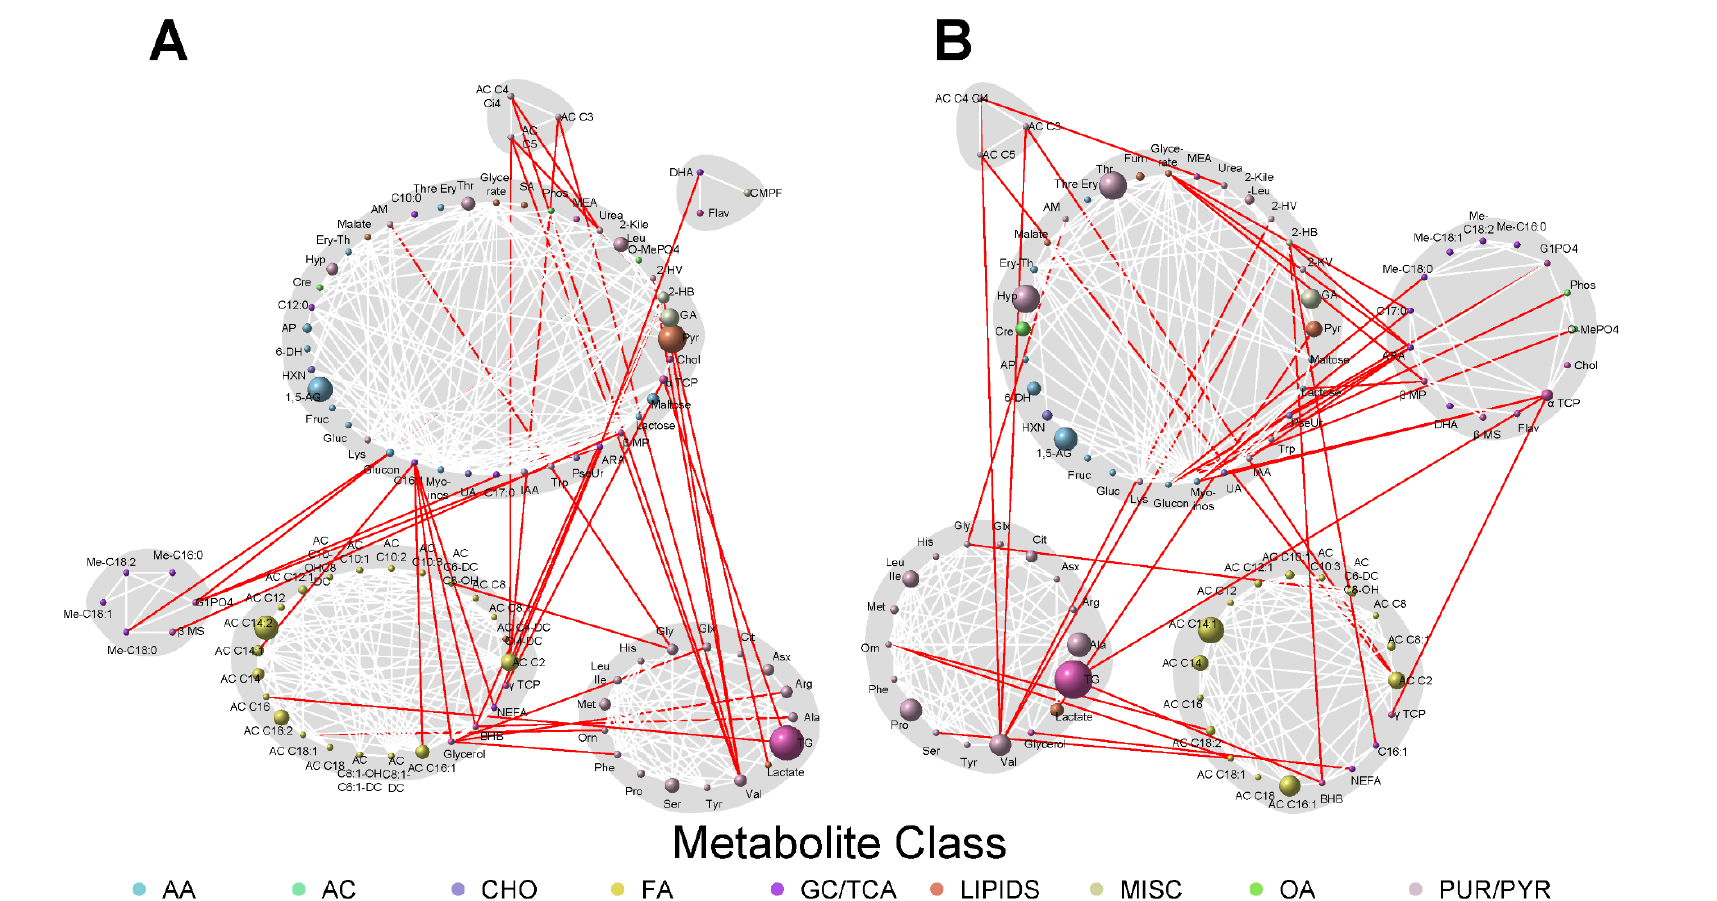
Figure 2. Maternal fasting ( A ) and 1 h ( B ) metabolite networks associated with newborn sum of skinfolds. Grey shading represents spin-glass communities within the metabolite networks. The lines between two nodes (edges) represent dependence among metabolite pairs conditional on all other metabolites in the network according to graphical lasso. Red edges represent dependencies for metabolites in different spin-glass clusters and white edges represent dependencies for metabolites within the same spin-glass cluster. The node size of each individual metabolite reflects the strength of the association with each newborn outcome. A larger node size indicates a more robust association. Nodes are colored by metabolite class as described in Figure 1. Metabolites are abbreviated as per the legend for Figure 1.